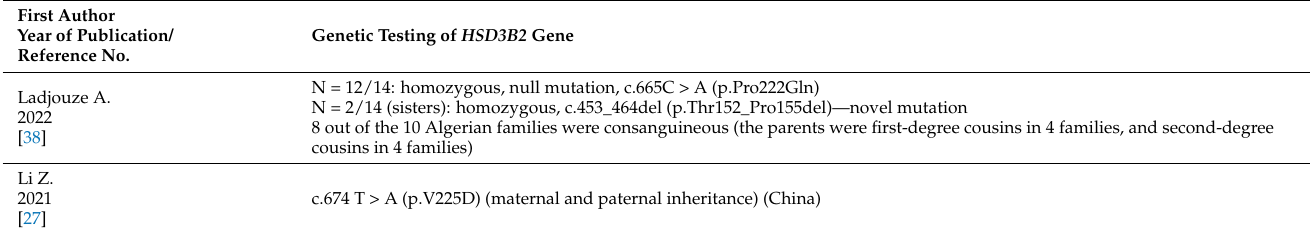
Table 3. Genetic testing in patients diagnosed with 3 β HSD2 deficiency, according to orig- inal studies/case reports published on PubMed within the last decade (starting from 2022) (References: